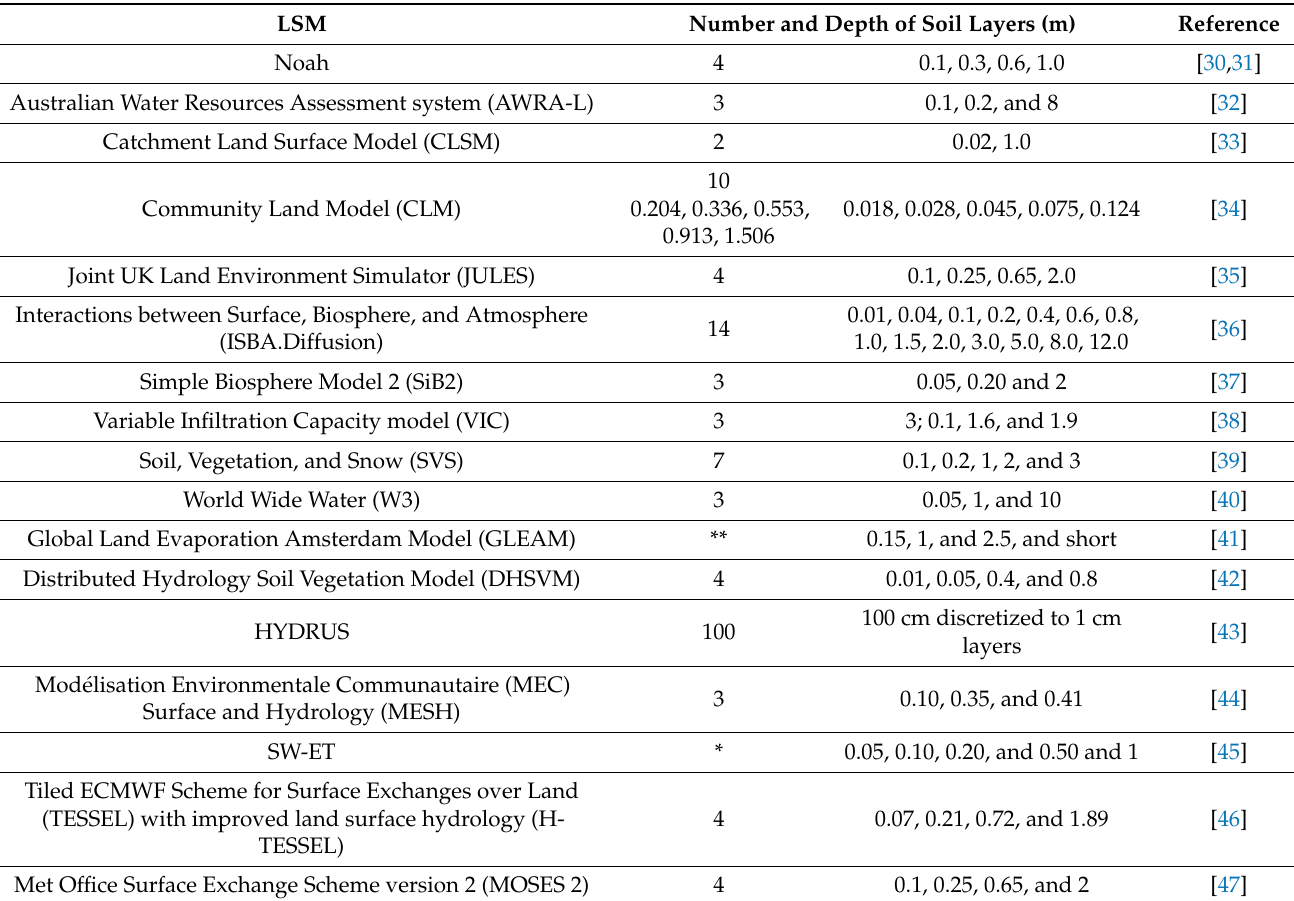
Table 1. The layering assumptions in LSMs; **: depends on land cover, tall vegetation fraction 0.15 and 1, bare soil 0.15. *: Discretized to